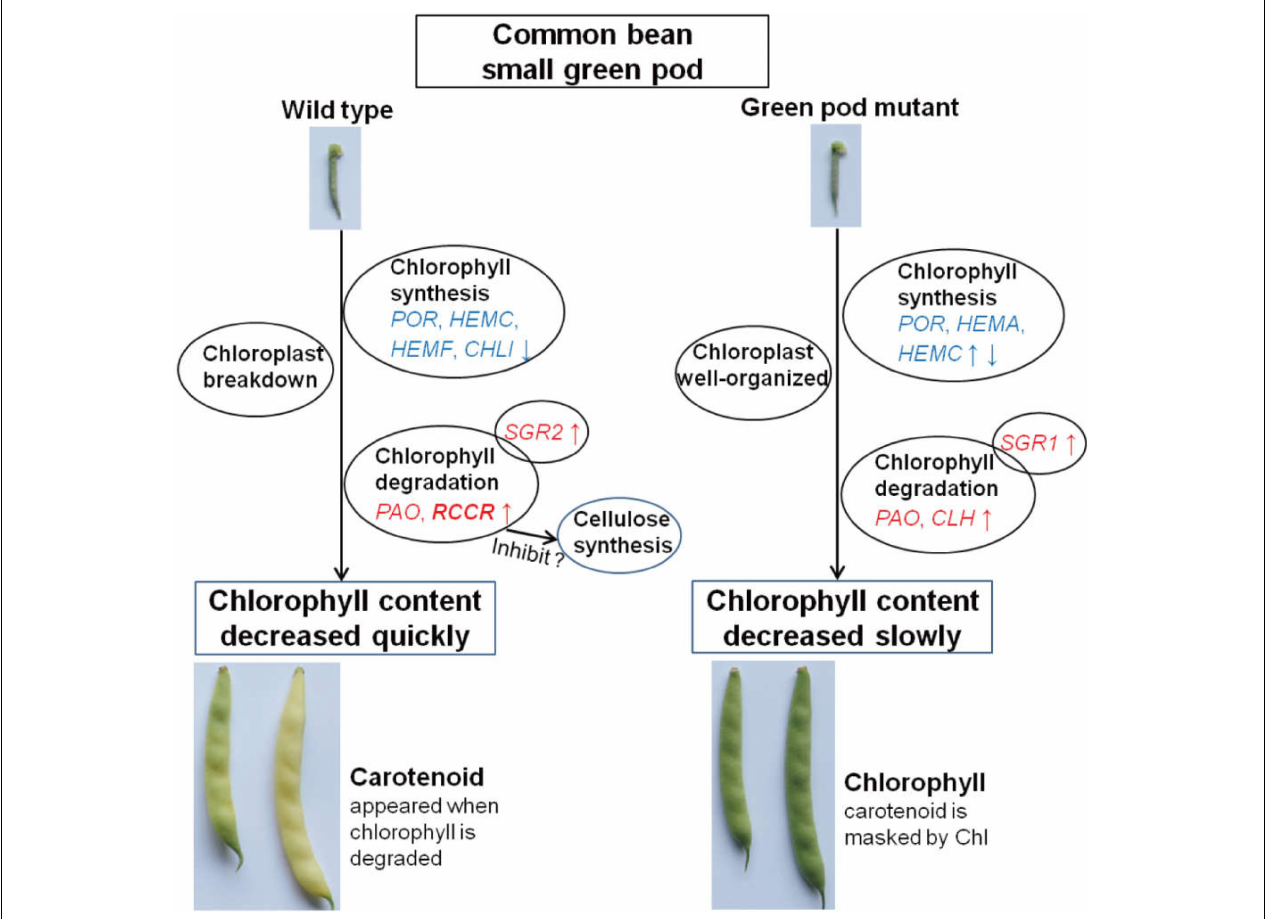
FIGURE 7 | The proposed mechanism model of color conversion of the wild type and green pod mutant.